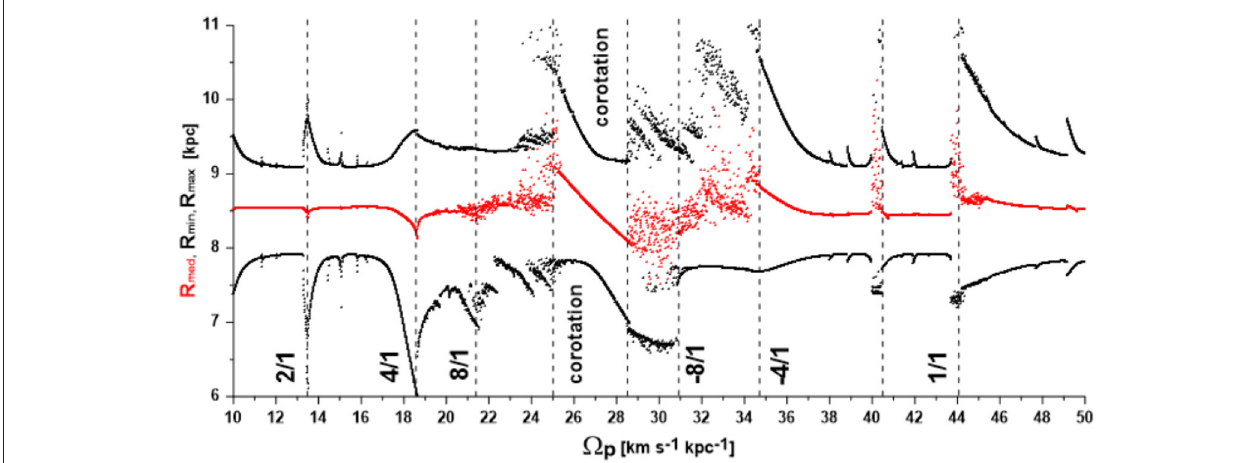
FIGURE 10 | Dependence of the orbital radius of the Sun on the value of the spiral pattern speed (cid:127) p . The averaged (red) and minimal/maximal (black) values of the R –variable calculated over 10Gyr are presented as a function of (cid:127) p . The vertical dashed lines indicate the locations of the epicyclic (Lindblad) resonances, as well as the (cid:127) p interval where the solar orbit is in corotation with the spiral pattern (25–29kms − 1 kpc − 1